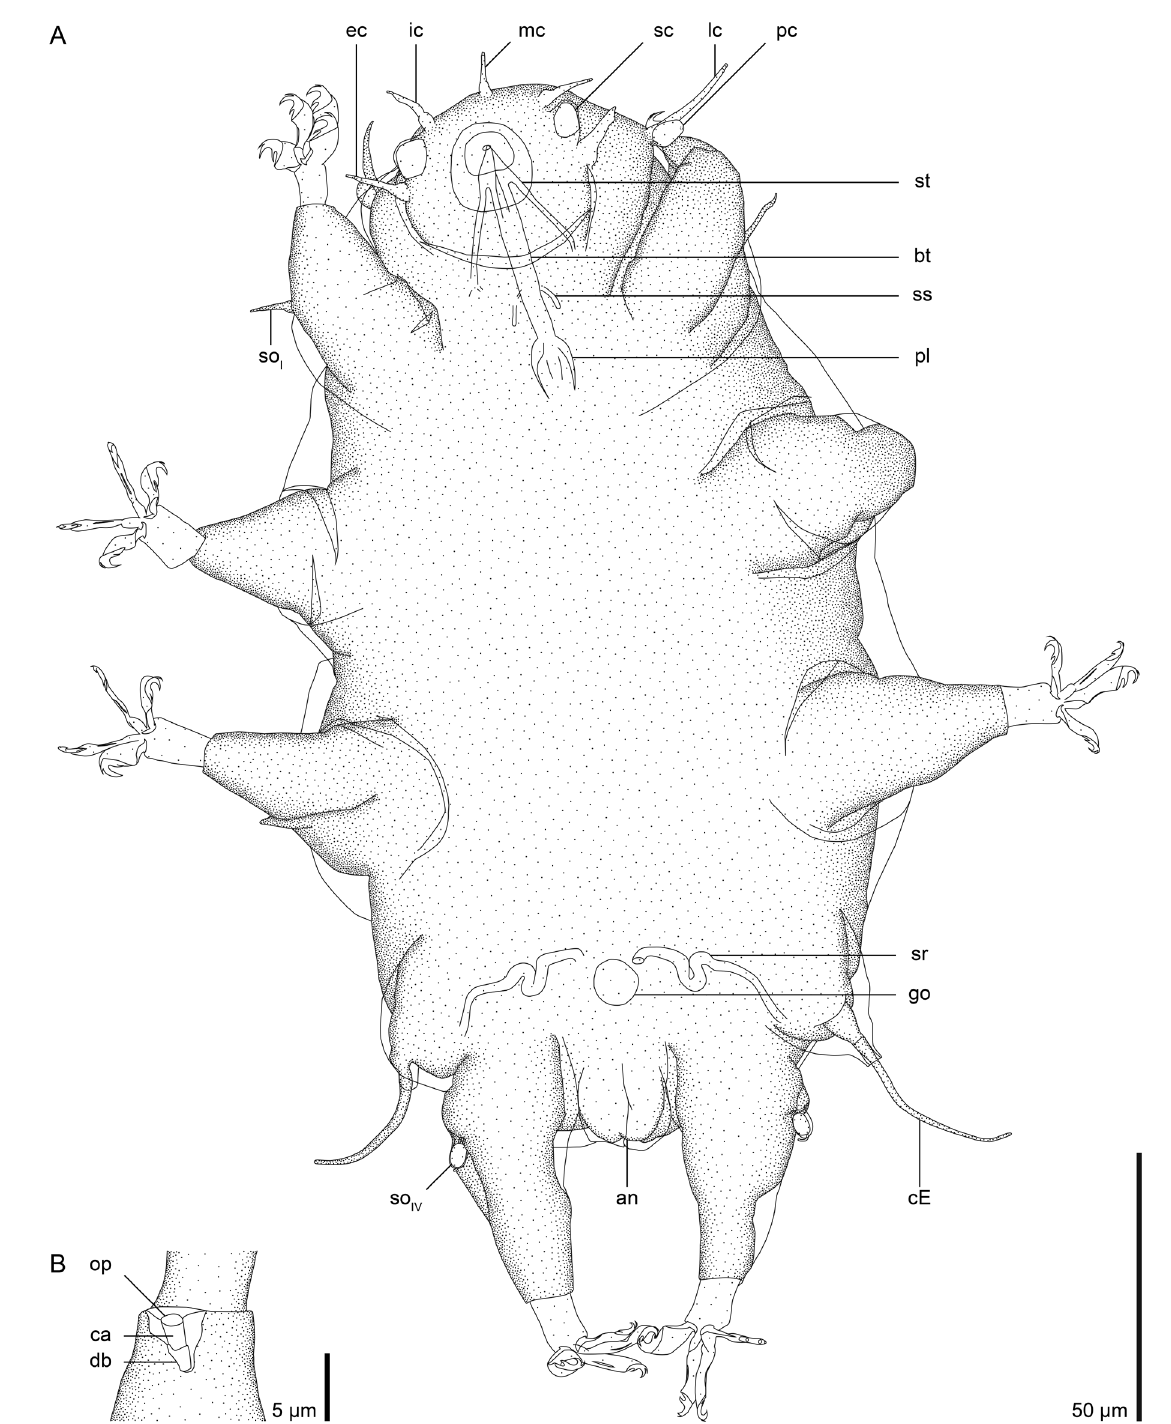
Figure 1. Drawings of Cyaegharctus kitamurai gen. et sp. nov., holotype KUZ Z2624. A. Habitus (ventral view). B. Leg IV pocket organ. an anus, bt buccal tube, ca cavity, cE cirrus E, db dense body, ec external cirrus, go female gonopore (detail not available), ic internal cirrus, lc lateral cirrus, mc median cirrus, pc primary clava, pl placoid, op opening, sc secondary clava, so